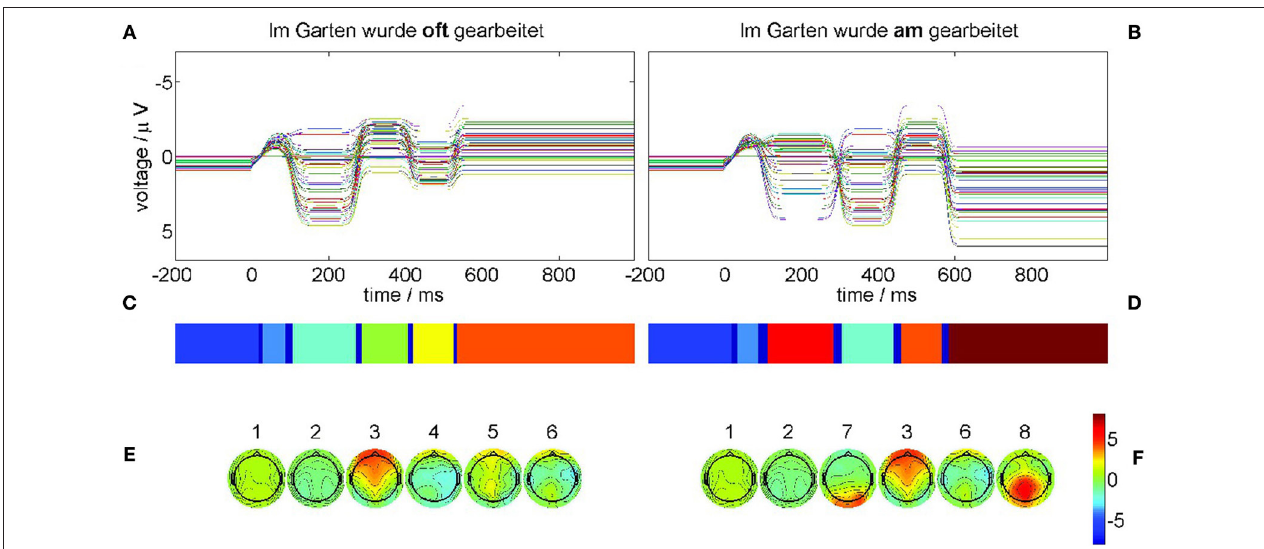
FIGURE 11 | Neural field simulation and its optimal recurrence grammar partition for experimental data from Frisch et al. [44]. The panels (A,C,E) show results for the correct condition (22-a), the panels (B,D,F) for the phrase structure violation condition (22-b). (A,B) The time series of the simulated EEG channels in the respective condition. (C,D) Optimal encodings p aligned through Hausdorff clustering. (E,F) Centers of gravity as time-averaged spatial scalp topographies. The P600 ERP component corresponds to segment